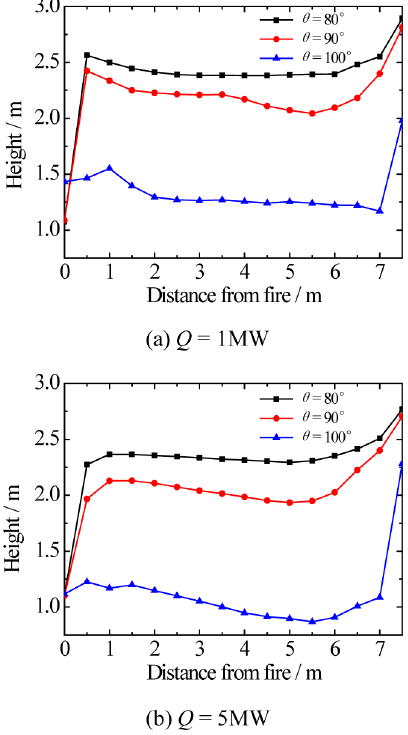
Fig. 14. Smoke layer height in the fire room varied with the distance from the fire in the y